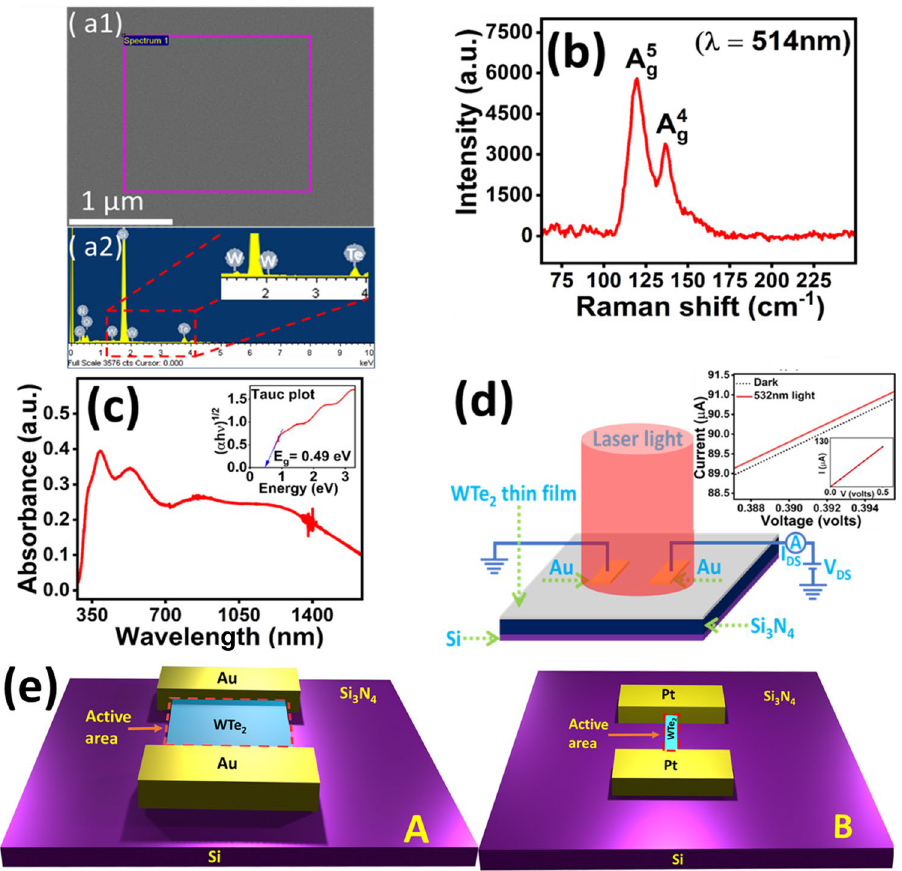
Figure 1. Deposition and characterization of WTe 2 films : ( a1 ) Shows FESEM image along with EDS spectra ( a2 ) of the selected portion. ( b ) Represents Raman spectra of the film. ( c ) Shows the UV absorption spectra and estimation of bandgap (inset). ( d ) Schematics of the optoelectronic measurements and curve in the inset represents IV characteristics of the film. ( e ) Different device configurations used in this study. Deposition of WTe 2 films using shadow masks and gold pads (A). FIB etched WTe 2 films and Pt contacts